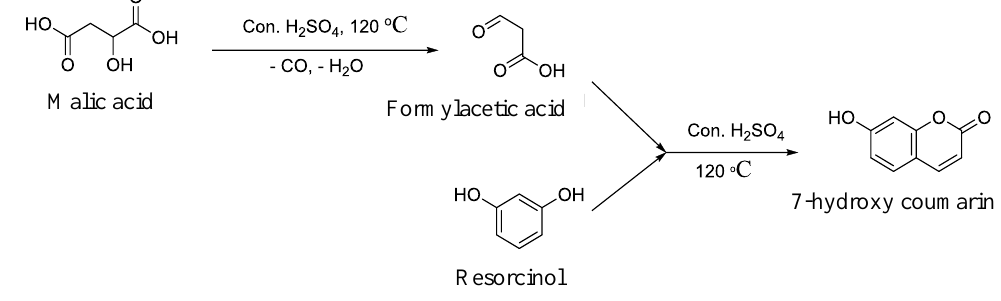
Figure 5. Reaction scheme for the synthesis of 7-hydroxy coumarin